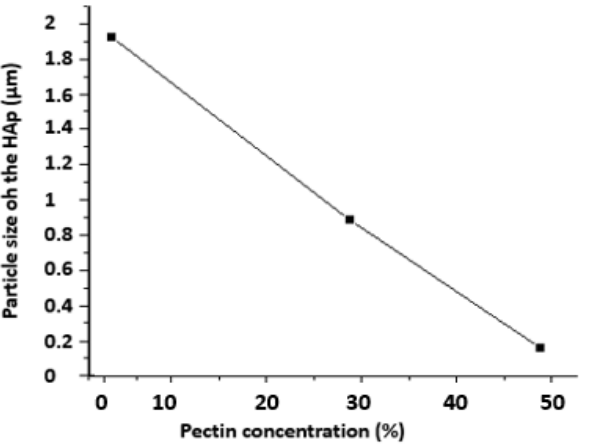
Figure 4. Particle Size of HAp/Pectin Nanoparticles.